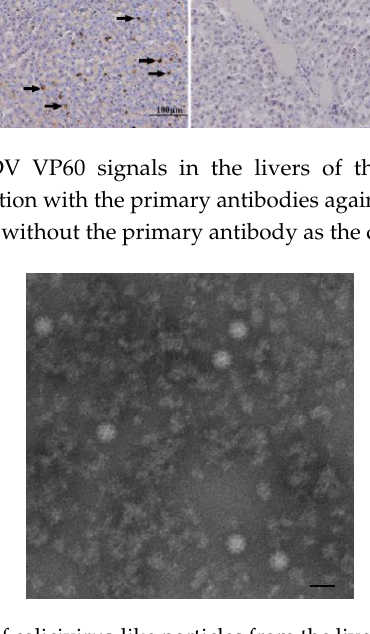
Figure 4. Electron micrograph of calicivirus-like particles from the liver homogenate of diseased Alpine musk deer. Bar: 50